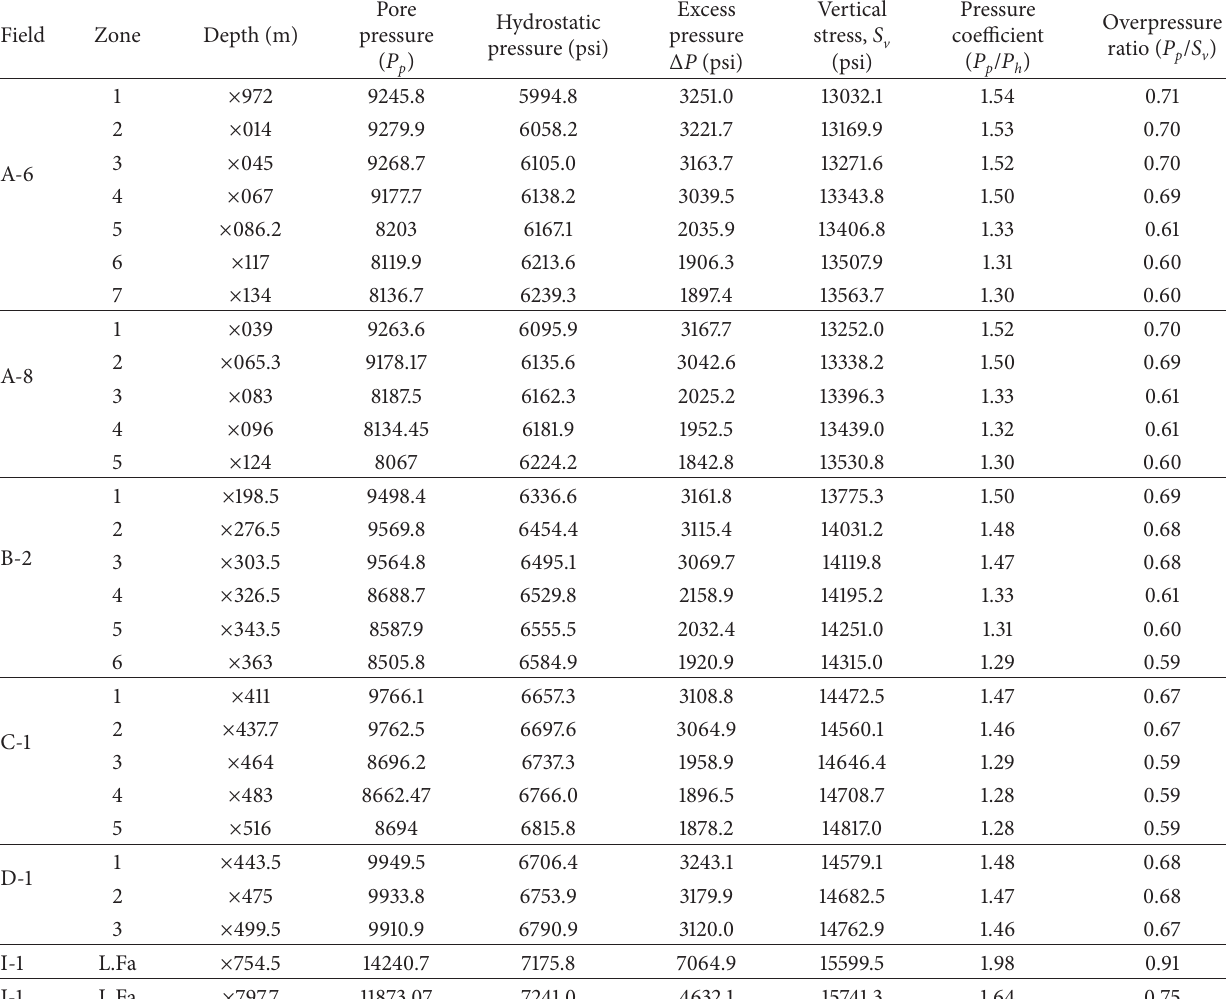
Table 2: Pressure characteristics of the Fahliyan reservoir layers of the fields under study. The zones with similar numbers are not age- equivalent